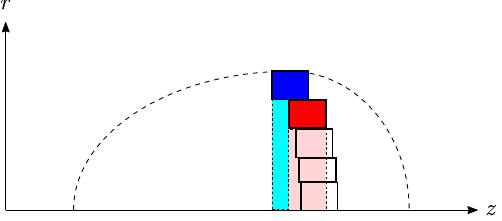
FIG. 3. Modeling a warped slice in a bunched beam using hollow cylinders. The dashed line indicates the entire bunched